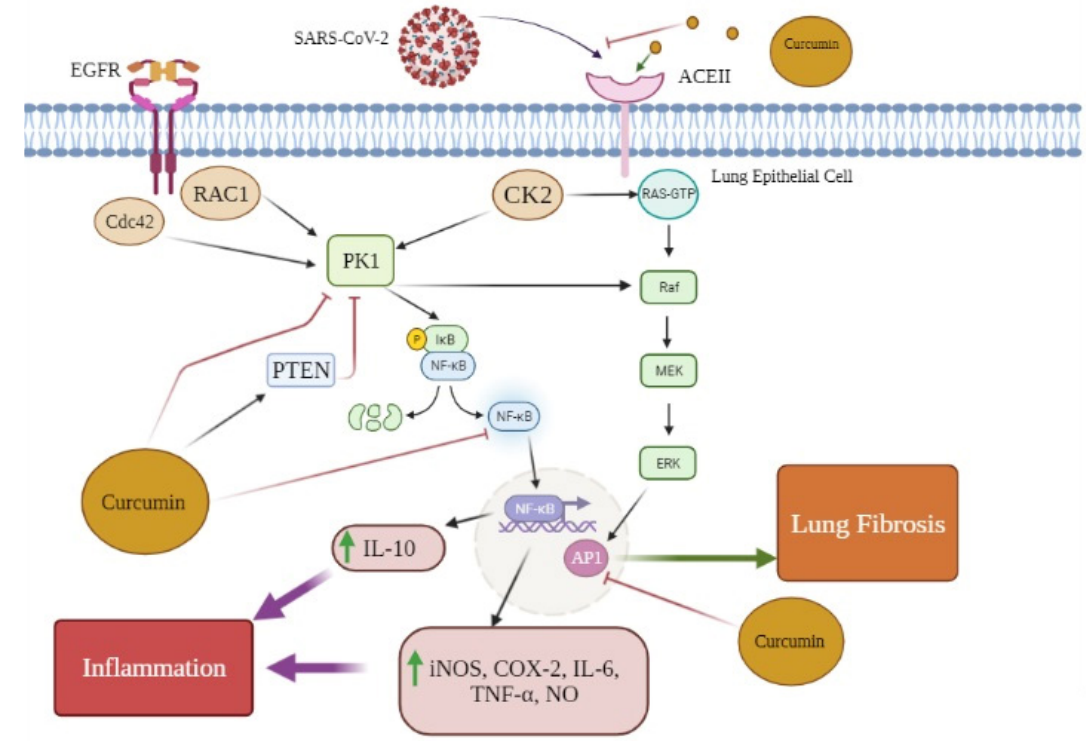
Figure 3. Schematic illustration of the action mechanisms of curcumin against SARS-CoV-2. Note . SARS-CoV-2: Severe acute respiratory syndrome coronavirus 2. Cdc42: Cell division cycle 42; RAC1: Rac family small GTPase 1; PK1: Protein kinase 1; CK2: Casein kinase 2; PTEN: Phosphatase and tensin homolog deleted on chromosome ten; MEK: Mitogen-activated protein kinase; ERK: Extracellular signal-regulated kinase; iNOS: Inducible nitric oxide ‎ synthase; COX-2: Cyclooxygenase-2; IL: Interleukin; NO: Nitric